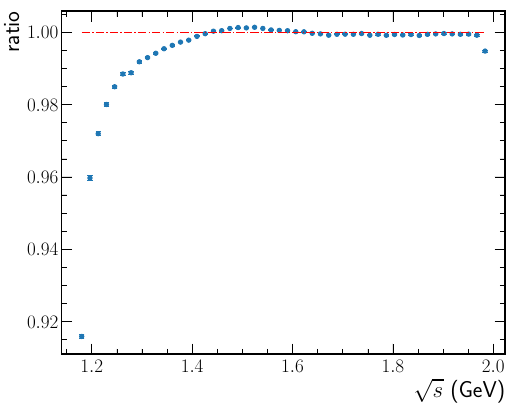
Figure 14. An example of the ratio of the nu- merical solution of eq. (1.5) to the model Born cross section, averaged over 10 5 numerical ex- periments. The parameter σ E is small com- pared to the distance between the c.m. energy points and is equal to 2 MeV. The numerical solution is obtained using the naive